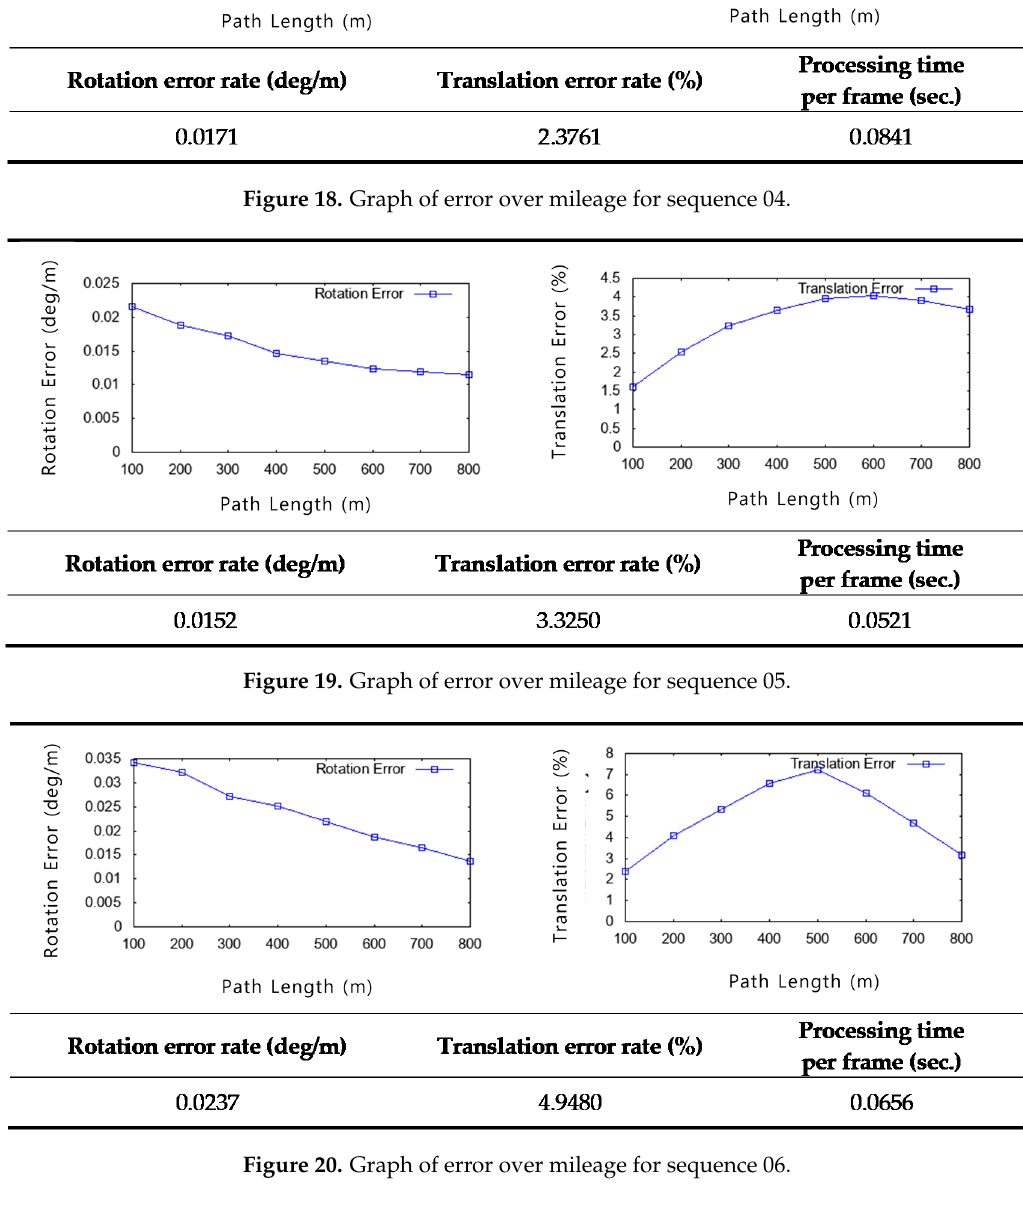
Figure 21. Graph of error over mileage for sequence 07. Figure 22. Graph of error over mileage for sequence 08.